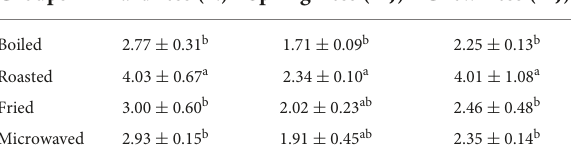
TABLE 2 Changes in the texture of heating scallops.